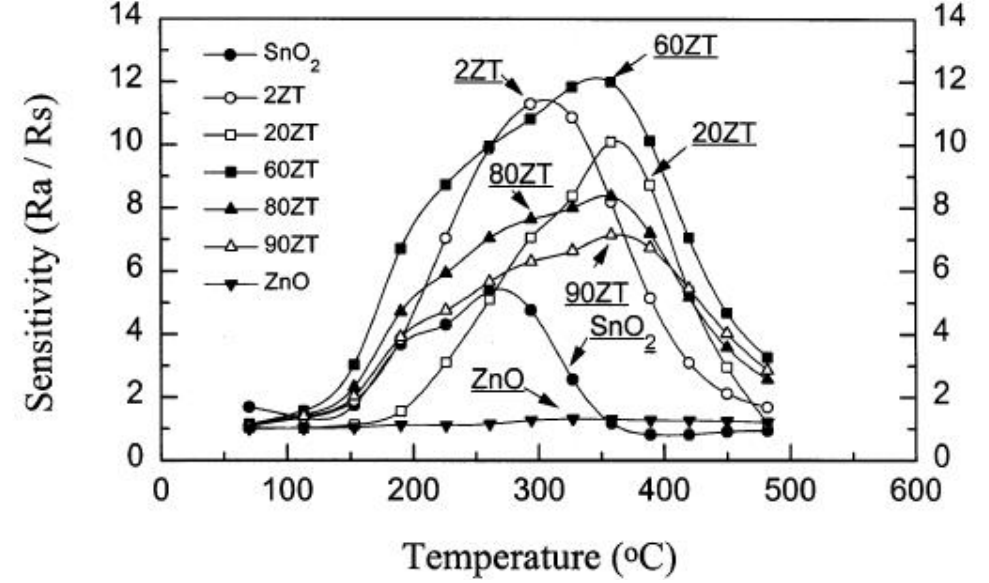
Figure 4. Temperature dependence of CO sensitivity (200 ppm) of SnO ZnO-SnO composites. 20 ZT means 20 mol% ZnO–80 mol% SnO 2 the similar (adapted from